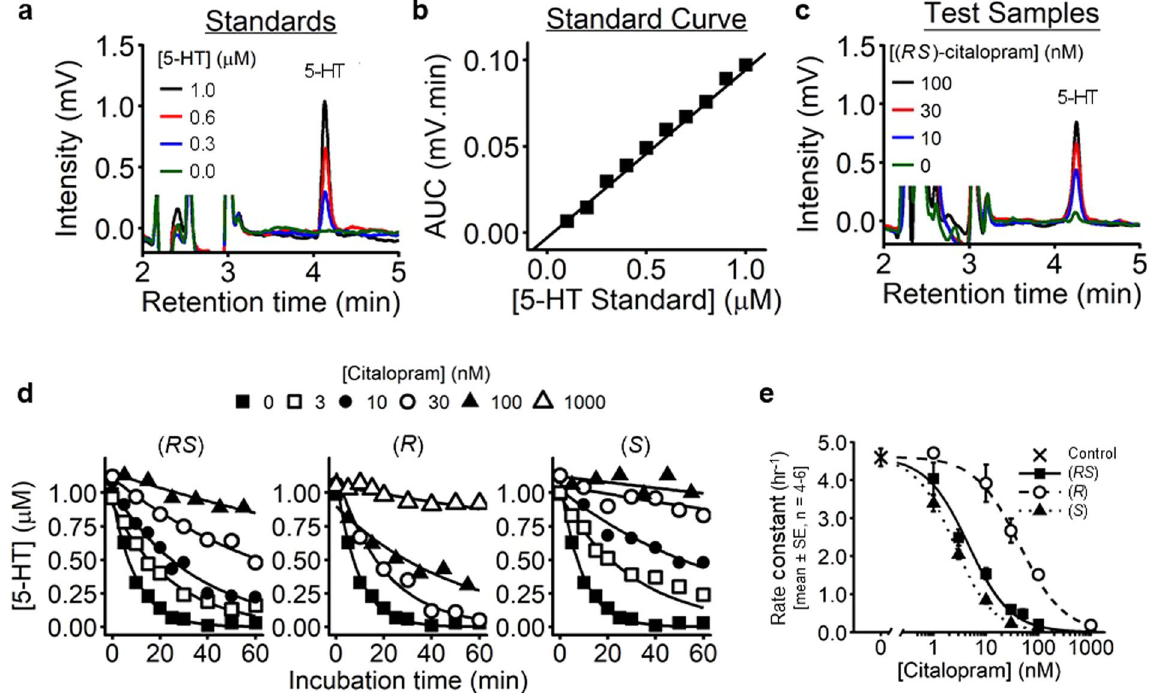
Figure 6. Inhibition of 5-HT uptake into platelets by citalopram. ( a ) Example HPLC chromatograms, showing peaks for known concentrations of 5-HT. ( b ) Peak AUCs, detected at 276 nm, were plotted against standard 5-HT concentrations to construct a calibration curve. ( c ) Example chromatograms used to quantify the supernatant 5-HT concentration 30 min after the addition of 1 µ M 5-HT to WP. ( d ) Profiles showing the reduction in supernatant 5-HT over time. Uptake was blocked by increasing concentrations of ( RS )-, ( R )- and ( S )-citalopram. Kinetic profiles (each with 6–12 time points) were used to determine rate constants of uptake ( k u ) under differing citalopram conditions. ( e ) The concentration-dependent effect of ( RS )-, ( R )- and ( S )- citalopram (0–1,000 nM) on k u was fitted to the 4PL model using NONMEM 7.3 and nested models compared using Likelihood Ratio Tests. Each citalopram preparation abolished 5-HT uptake in a manner consistent with non-cooperative 1:1 binding ( P = 0.099, LRT, χ 2 = 10.7, df = 6. H 0 : n H = 1, Max = 0; H 0 : n H ≠ 1, Max ≠ 0 for each preparations of citalopram. N = 13 separate